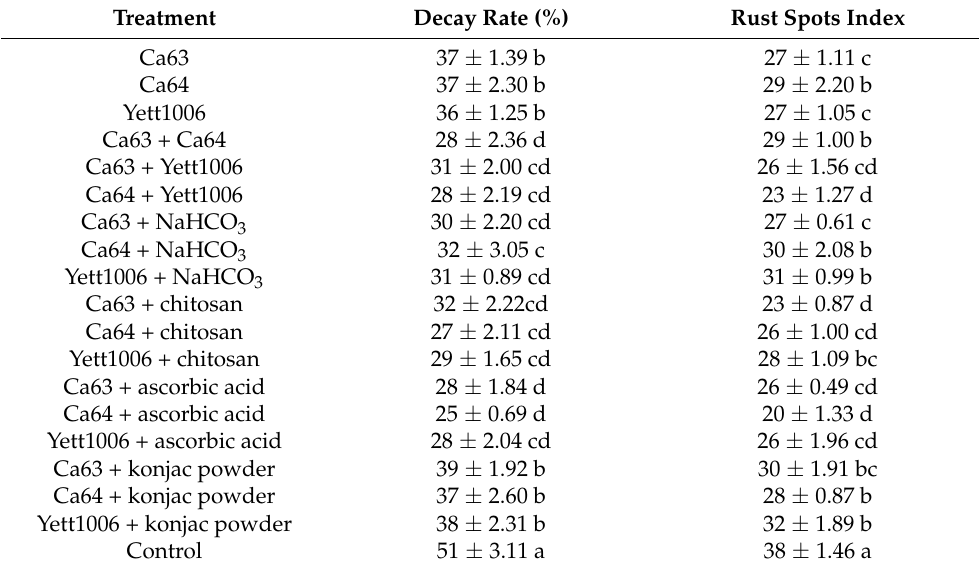
Table 7. Evaluation of decay rate and rust spots index of snap beans following different yeast strains and yeast strains combination treatments.